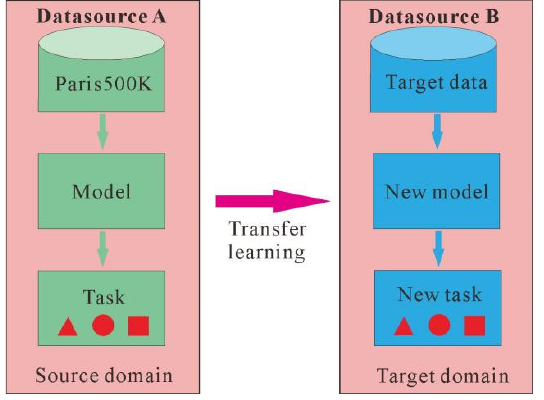
Figure 5. Schematic diagram of transfer learning process.